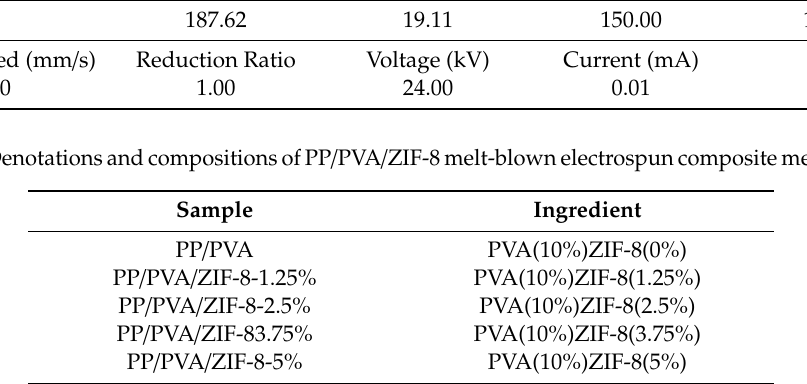
Figure 1. Flow chart of preparation of polypropylene / polyvinyl alcohol / zeolite imidazole frameworks-8 (PP / PVA / ZIF-8) melt-blown electrospun composite membranes. Table 3. Parameters of electrospinning process.